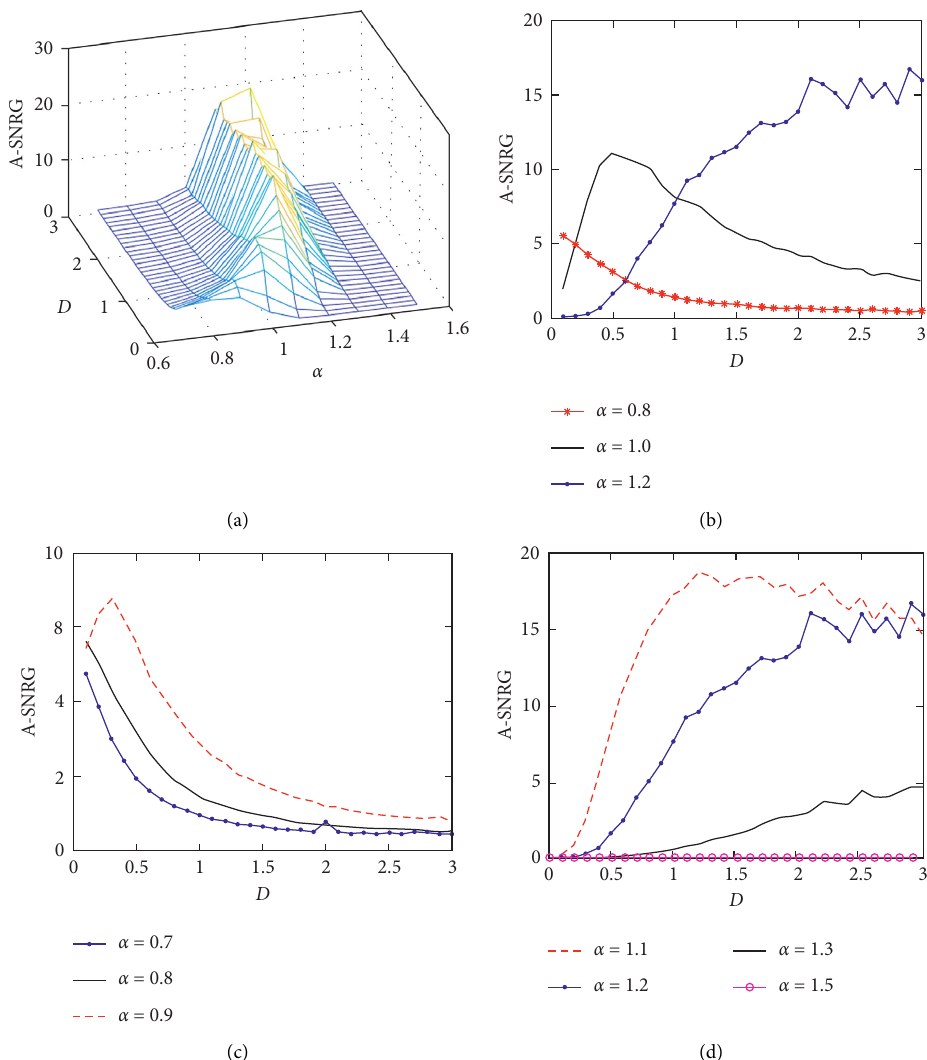
Figure 12: (a) A-SNRG of SR with asymmetric depth and width of potential well as a function of noise intensive D and asymmetric factor with different values of α . (b) A-SNRG of SR with asymmetric depth and width of potential well as a function of noise intensive D for different values of asymmetric factor with α , (c) α < 1 and (d) α >